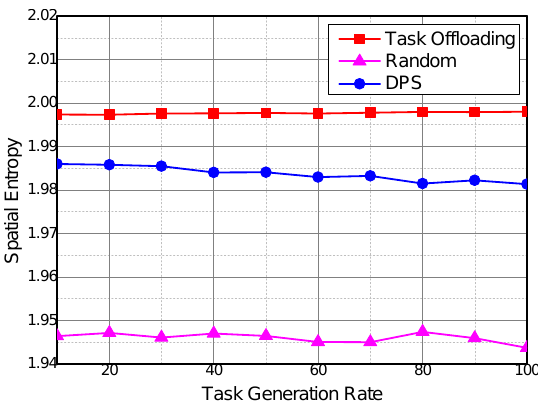
Figure 14. Spatial entropy under different task generation rates.